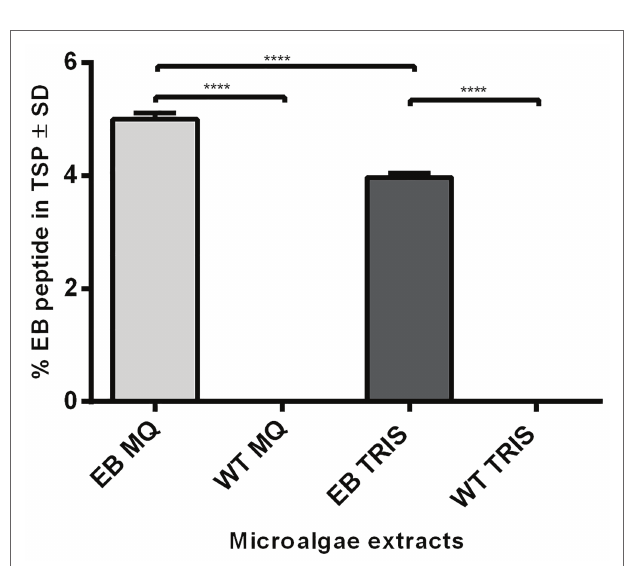
FIGURE 4 | ELISA quantification of EB peptide produced in transformed microalgae. The EB concentration was estimated in transformed (EB) microalgae extracts with a mouse anti-EB peptide polyclonal antibody, using wild-type (WT) microalgae as controls. The amount of EB was expressed in percentages of total soluble protein (TSP; ANOVA one way, p < 0.001) with Tukey multiple comparisons test (**** = 0.0001). (MQ): Milli Q water extracts; (TRIS): Tris Buffer